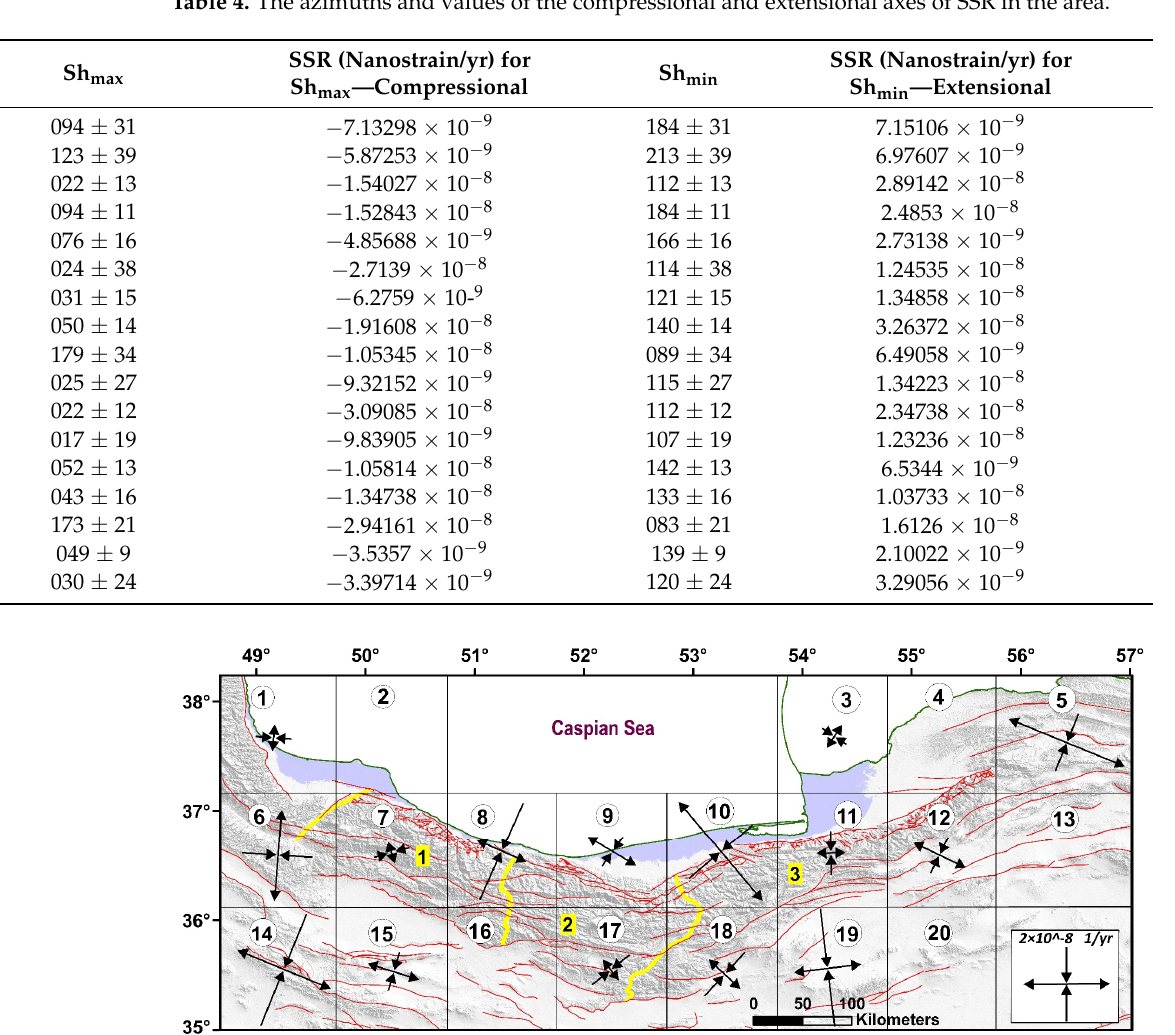
Figure 4. The direction and the magnitude of principal axes of SSR in the area. Labels within grids show grid number. Numbers 1, 2, and 3 are location of the West Alborz, Central Alborz, and East Alborz, respectively which are separated by yellow lines.